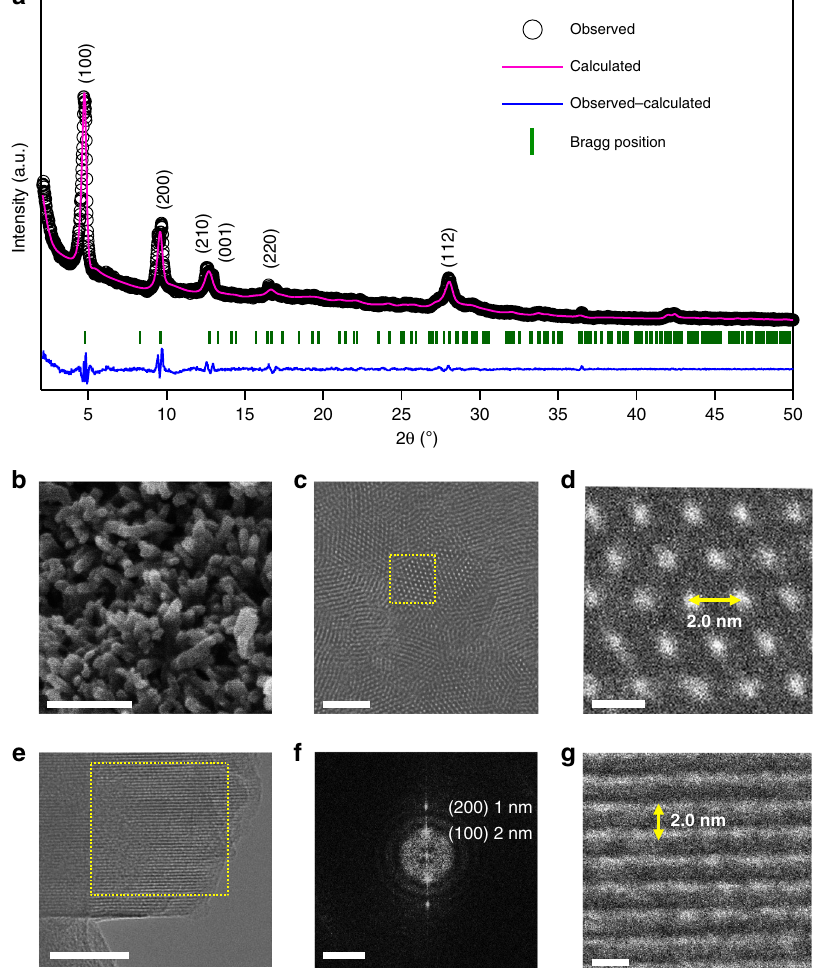
Fig. 2 2D Chemical structure and structural analysis of Cu 3 (HHTP) 2 . a Rietveld re fi nement of PXRD patterns. b FE-SEM image of Cu 3 (HHTP) 2 , scale bar: 200 nm. c LD-HRTEM image of Cu 3 (HHTP) 2 at a low resolution, scale bar: 20 nm. d LD-HRTEM image of Cu 3 (HHTP) 2 along the [001] zone axis, indicating a hexagonal pore packing with d 100 = 2.0 nm, scale bar: 2 nm. e – g LD-HRTEM images at ( e ) low and ( g ) high resolution along the [010] direction. Scale bars in ( e ) and ( g ) are 50 and 2 nm, respectively. f An FFT pattern of the yellow square in ( e ), scale bar: 2 nm −